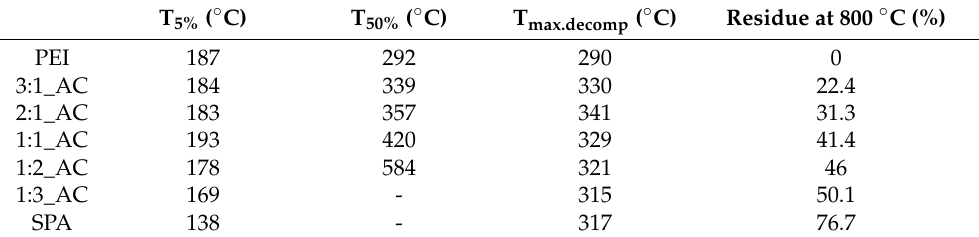
7 Figure 7. TG ( left ) and DTG ( right ) curves for PEI:SPA at different ratios under N 2 . Table 3. TG and DTG curve results for different PEI:SPA ratios under N 2